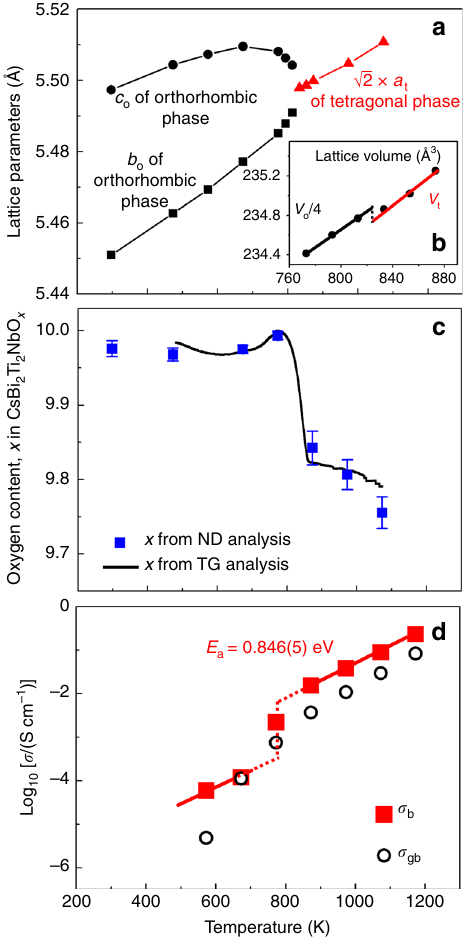
Fig. 1 Temperature dependences of lattice parameters, oxygen content, and conductivities. Lattice parameters ( a ) and reduced lattice volume ( b ) of CsBi 2 Ti 2 NbO 10 − δ , which were re fi ned using synchrotron X-ray powder diffraction data measured in situ at high temperatures in static air on heating. The subscripts o and t denote orthorhombic and tetragonal, respectively. c Oxygen contents of CsBi 2 Ti 2 NbO 10 − δ on heating, which were obtained by thermogravimetric (TG) analysis in dry air (black line) and calculated from occupancy factors re fi ned using in situ neutron-diffraction (ND) data in vacuum (blue marks). d Bulk electrical conductivity σ b and grain boundary conductivity σ gb of CsBi 2 Ti 2 NbO 10 − δ in dry air on